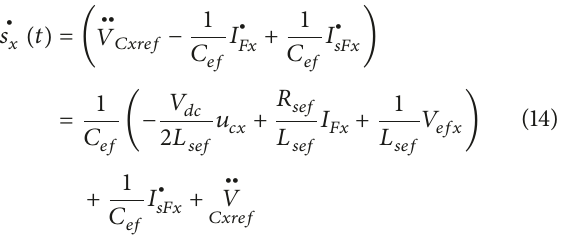
Figure 5: Membership function for fuzzy rule